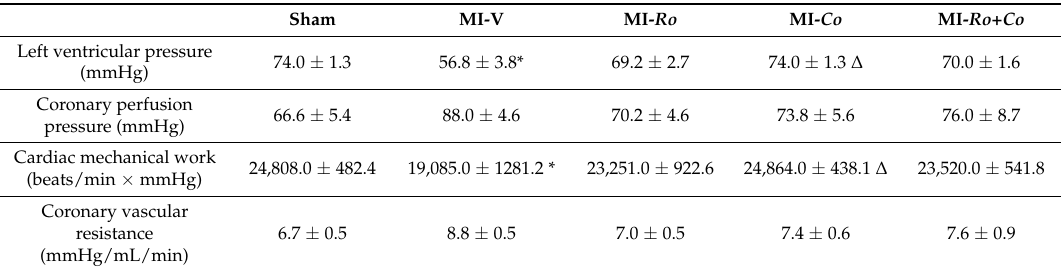
Table 2. The effect of Rosmarinus officinalis ( Ro ), Crataegus oxyacantha ( Co ), and the combination of the extracts ( Ro+Co ) administration on hemodynamic parameters obtained by the Langendorff method. Sham MI-V MI- Ro MI- Co MI- Ro+Co Left ventricular pressure 74.0 ± 1.3 56.8 ± 3.8* (mmHg) 66.6 ±